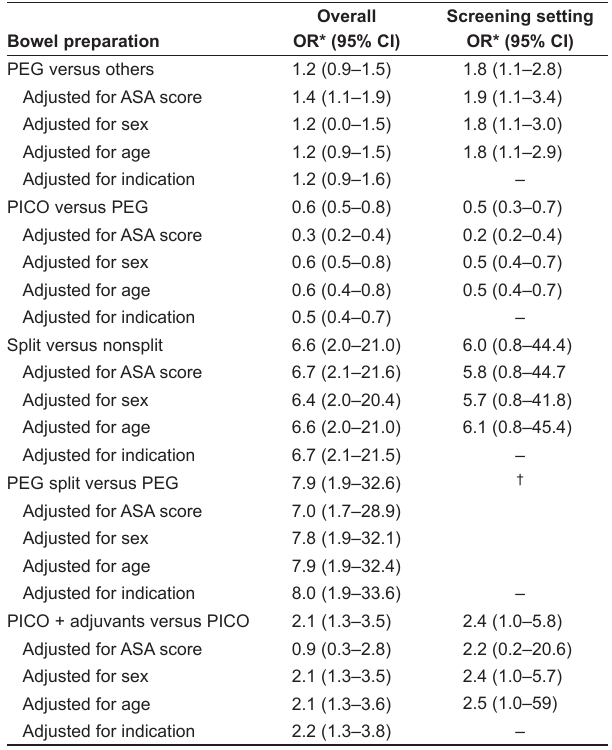
Statistical analysis: χ 2 analysis. *Crude and Mantel Haenszel OR reported